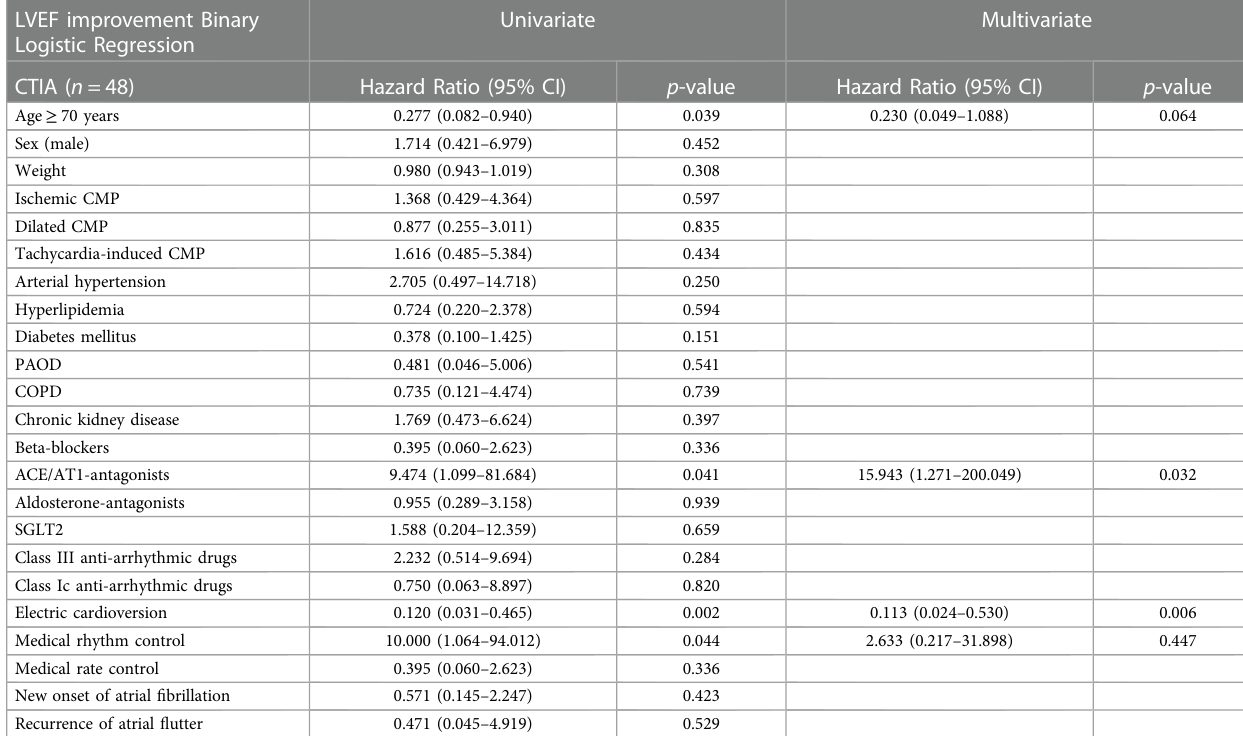
TABLE 4 Tabular overview of univariate and multivariate binary logistic regression of CTIA group with regard to various clinical characteristics and LVEF improvement. LVEF improvement